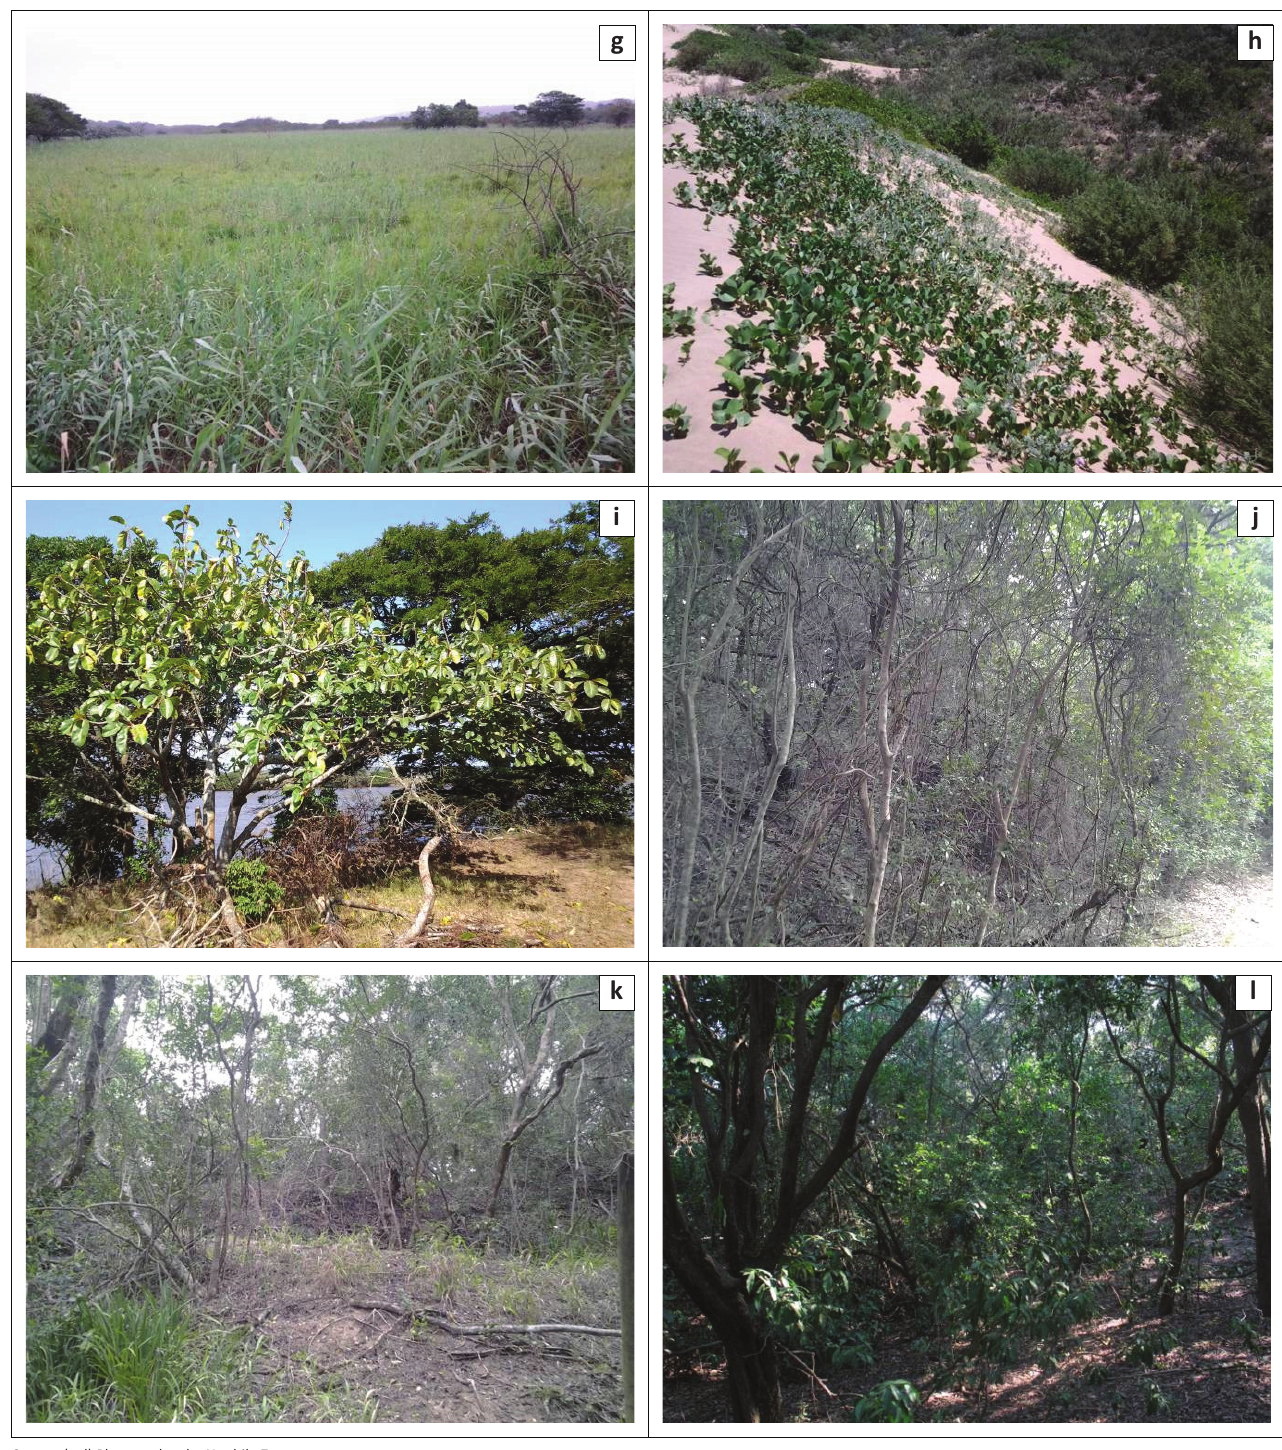
FIGURE 3 (Continues ...): Representative photographs of the uMlalazi Nature Reserve plant communities: (a) Salicornia meyeriana–Avicennia marina salt marsh community, (b) Bruguiera gymnorrhiza–Avicennia marina mangrove forest, (c) Phragmites australis–Juncus kraussii saline wetland, (d) Scaevola plumieri–Gazania rigens foredune community, (e) Typha capensis–Cyperus dives wetland community, (f) Digitaria eriantha–Dactyloctenium australe secondary coastal grasslands, (g) Stenotaphrum secundatum–Phragmities australis freshwater wetland, (h) Passerina rigida–Carpobrotus dimidiatus dune scrub community, (i) Adenopodia spicata–Vachellia robusta riverine woodland community, (j) Albizia adianthifolia–Chromolaena odorata disturbed coastal dune forest, (k) Tricalysia sonderiana–Apodytes dimidiata dune forest margin, (l) Gymnosporia arenicola–Protorhus longifolia coastal dune forest, (m and n) Carissa bispinosa–Mimusops caffra climax coastal dune